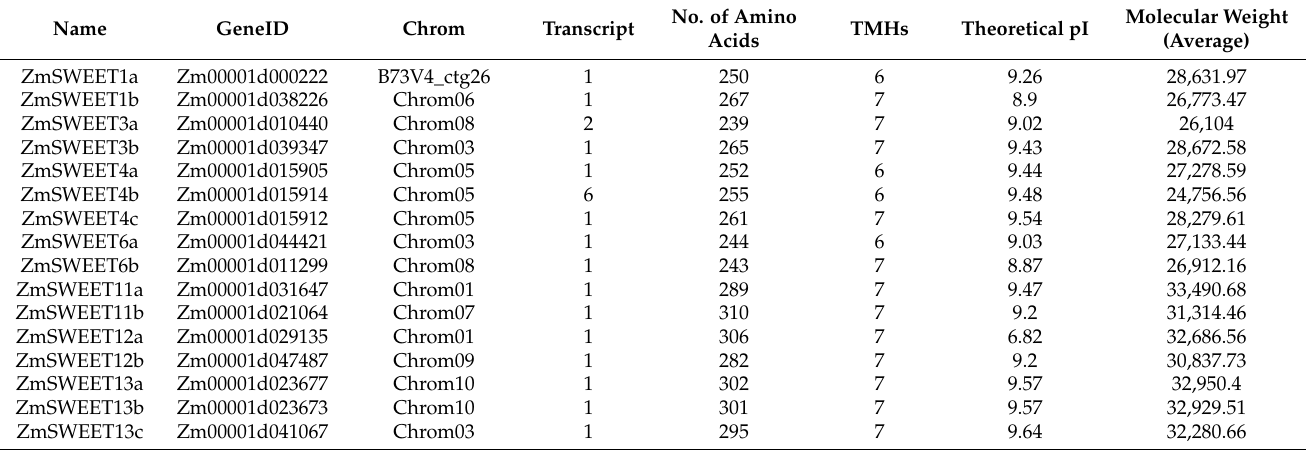
Table 1. The information of Sugar Will Eventually be Exported Transporter gene family in